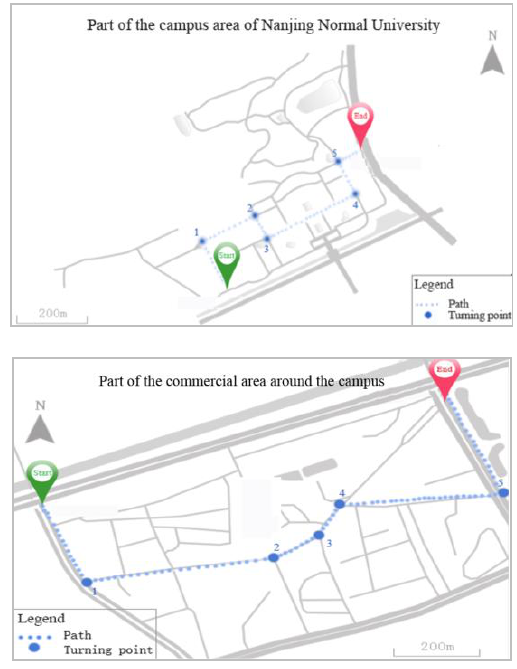
Figure 1. Experimental